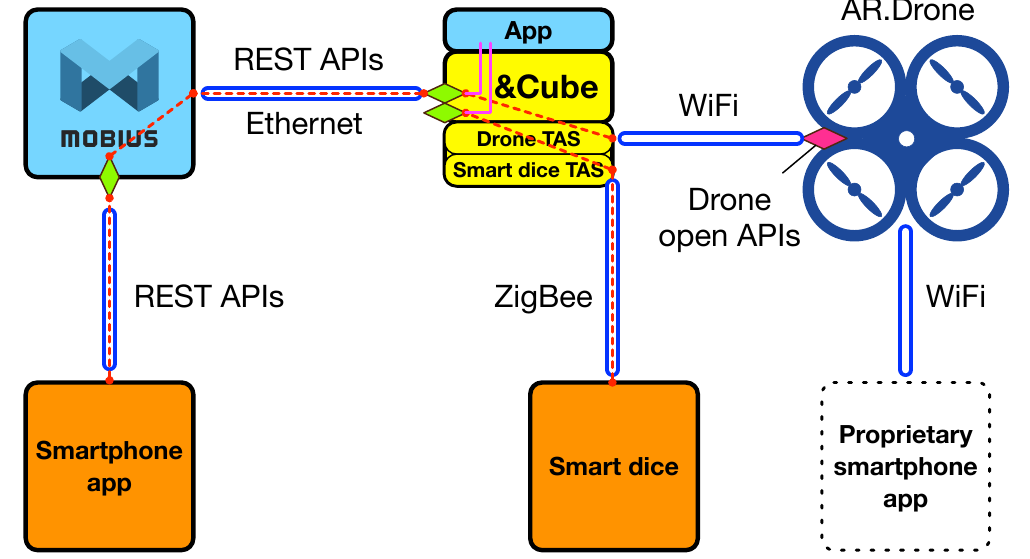
Figure 12. System architecture for the iDrone service